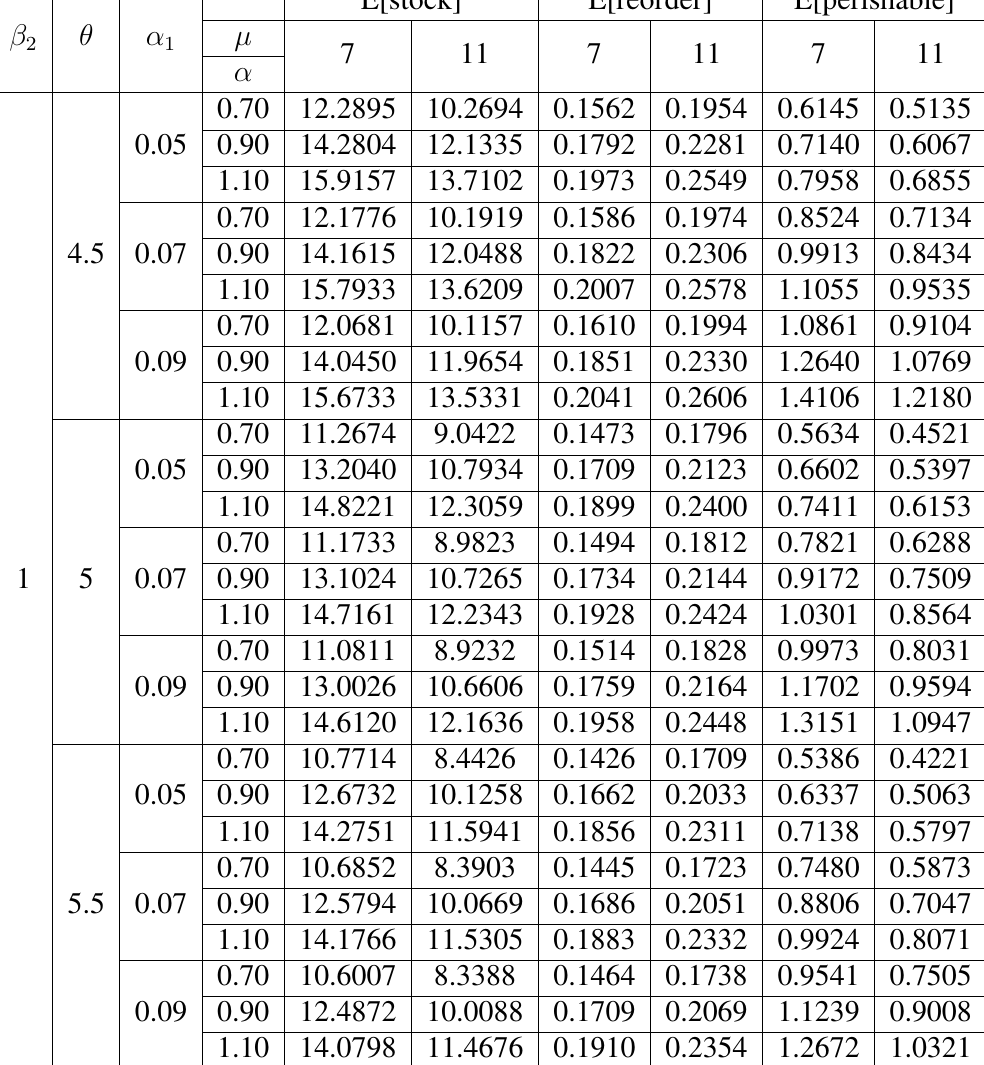
Table 7: Impact of E[psl], E[reorder and E[perishable] with the parameter variation β